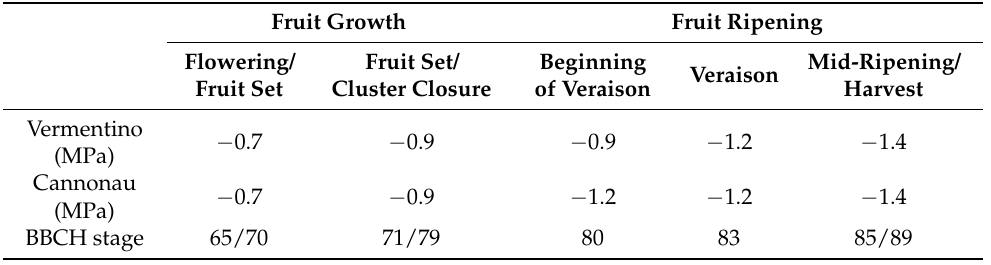
Table 1. Midday stem water potential (MPa) thresholds for the irrigation season. Fruit Growth Fruit Ripening Mid-Ripening/ Flowering/ Fruit Set/ Beginning Veraison Harvest Fruit Set Cluster Closure of Veraison Vermentino − 0.7 − 0.9 − 0.9 − 1.2 − 1.4 (MPa) Cannonau − (MPa)